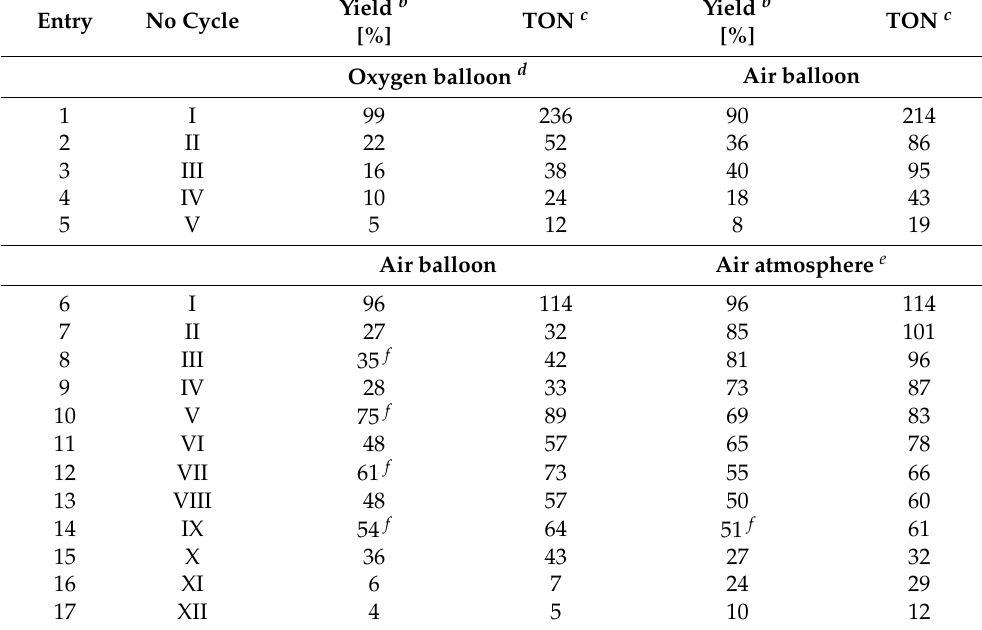
Table 2. The yields, turnover numbers (TON) and selectivity for catalytic oxidation of benzyl alcohol to benzaldehyde in consecutive catalytic cycles using N-AgNPs with various oxygen sources a . Yield b Entry No Cycle